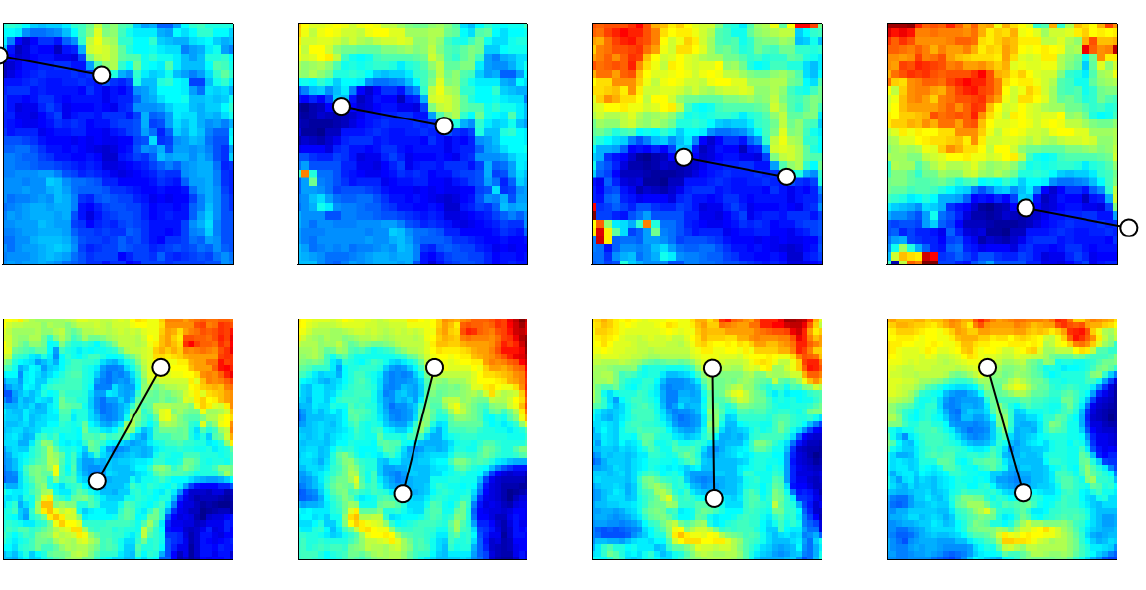
Figure 5. A series of 4 translated images (top row) and a series of rotated images (bottom row) used in Test 2. Markers are inserted into the images to illustrate the direction of the translation and the angles of the rotation, respectively.